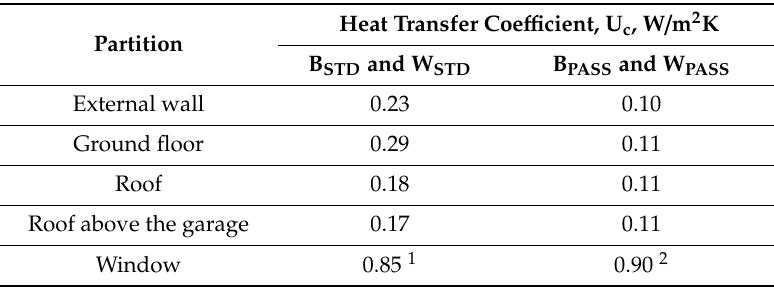
Table 1. Heat transfer coe ffi cients for the external